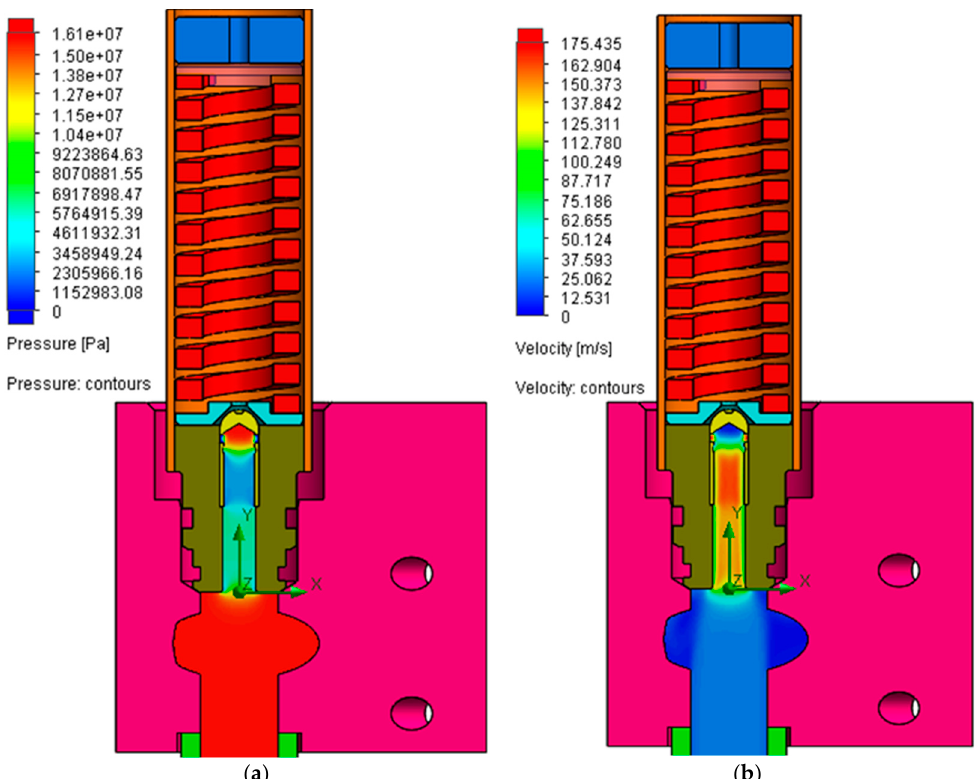
Figure 16. The variation maps of pressure ( p ) ( a ) and velocity ( υ ) ( b ) for a 0.0033 m 3 ·s -1 volume flow rate (200 L·min -1 ).